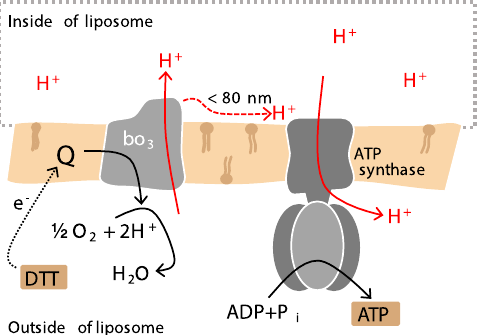
Figure 1. The experimental system. Cyt. bo 3 and ATP-synthase from E . coli were co-reconstituted in vesicles (a part of the membrane is shown). For measurements of protein-protein interactions, cyt. bo 3 and ATP-synthase were labeled with fluorophores (not shwon, see text). To measure the coupled activity, DTT and quinone were added, which initiates transmembrane proton transfer, driven by the quinol oxidase. The ATP-synthesis rate was monitored by measuring changes in luminescence that originates from added luciferase/luciferin. Proton transfer along the membrane surface is discussed in the Discussion section.